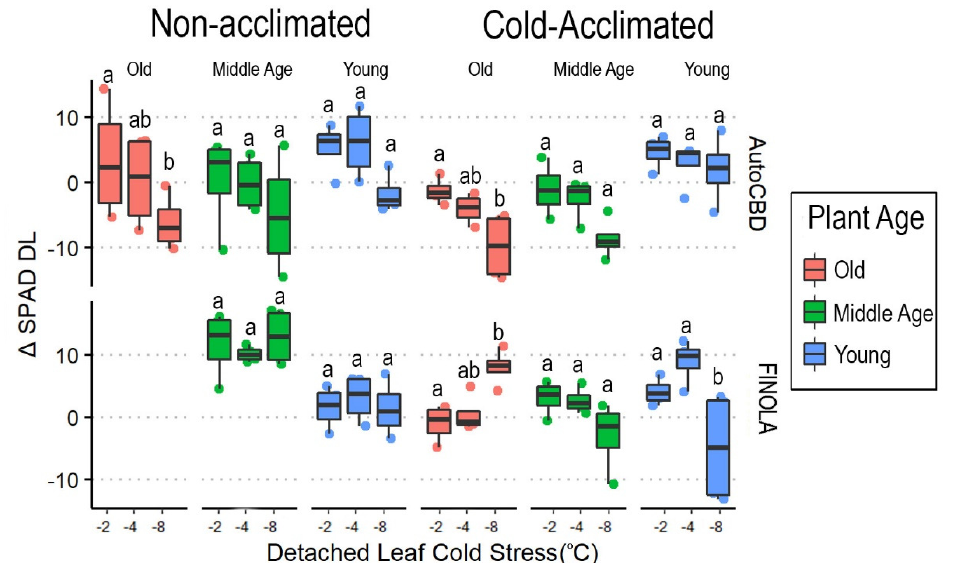
Figure 5. Δ SPAD DL box plots comparing detached-leaf cold stress and plant age. Data represent the difference in mean SPAD taken before whole-plant cold stress and after detached-leaf cold stress. Detached-leaf cold stress consisted of a single 3 h − 2 °C exposure, a single 3 h − 4 °C exposure, and a single 3 h − 8 °C exposure. Plant age treatments include oldest plants, middle-age plants, and youngest plants (68, 54, and 40 days old on the day of whole-plant cold stress, respectively). Lowercase letters indicate significant differences ( p < 0.05) between treatments (Tukey’s test). Electrolyte leakage as a result of cold intensity treatments (EL DL ) differed between cultivars (F = 17.108, p < 0.0001), plant age groups (F = 3.870, p < 0.05), and detached-leaf cold stress exposures (F = 12.316, p < 0.0001) (Table 3). Interactions among treatment groups were also observed in cultivar × detached-leaf cold stress (F = 4.086, p < 0.05), and cold acclimation × detached-leaf cold stress (F = 6.962, p < 0.01). Plants receiving − 8° C treatment most commonly had highest average EL values in both acclimated ‘AutoCBD’ (t = − 4.921, p < 0.0001) and ‘FINOLA’ (t = − 2.657, p < 0.05) across plant age and acclimation treatments (Supplementary File Table S2). 3.3. Cannabinoids and Weight Postharvest data were collected from only ‘AutoCBD’ plants (Supplementary File Ta- ble S3). Total CBD % decreased with cold acclimation (F = 119.173, p < 0.0001). Although no main effect of cold treatment was observed, there was an interaction between cold ac- climation, plant age, and cold treatment (F= 3.801, p < 0.01). Comparing the total CBD % showed that plants receiving no acclimation treatment had approximately twice the mean total CBD than the acclimation treatment group (Table 4, Figure 6). Similar effects of cold acclimation (F = 25.633, p < 0.0001) and plant age (F = 4.603, p < 0.05) were observed on total CBG after cold exposure, in addition to an effect of cold stress treatment (F = 2.912, p < 0.05). CBG was the cannabinoid that showed the fewest responses to treatments (Figure 7). Table 4. Summary of effects of cultivar, cold acclimation, plant age, whole-plant cold stress, and their interactions and mean values for post-harvest properties of ‘AutoCBD’. Mean